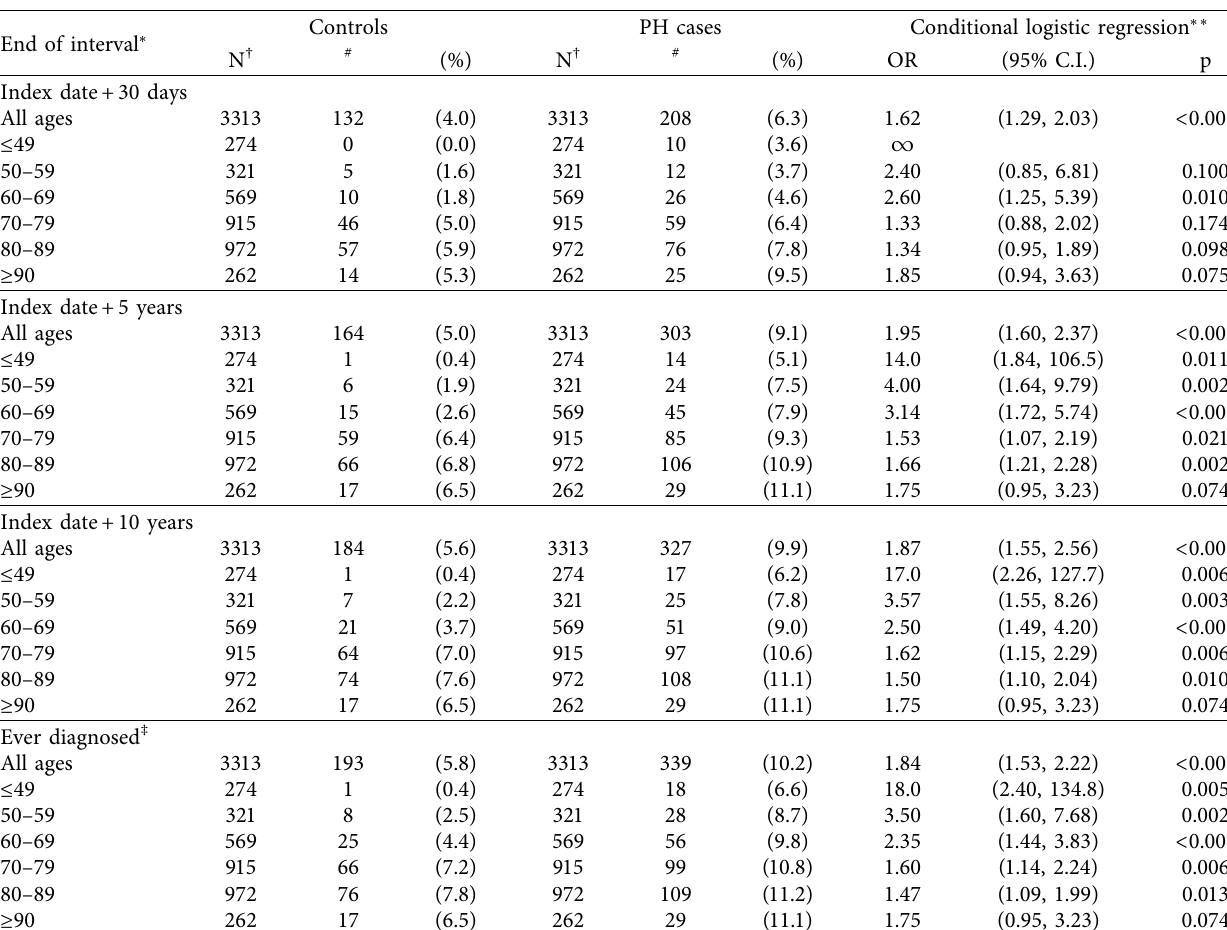
Table 1: Frequency of MGUS diagnosis among PH cases and controls.